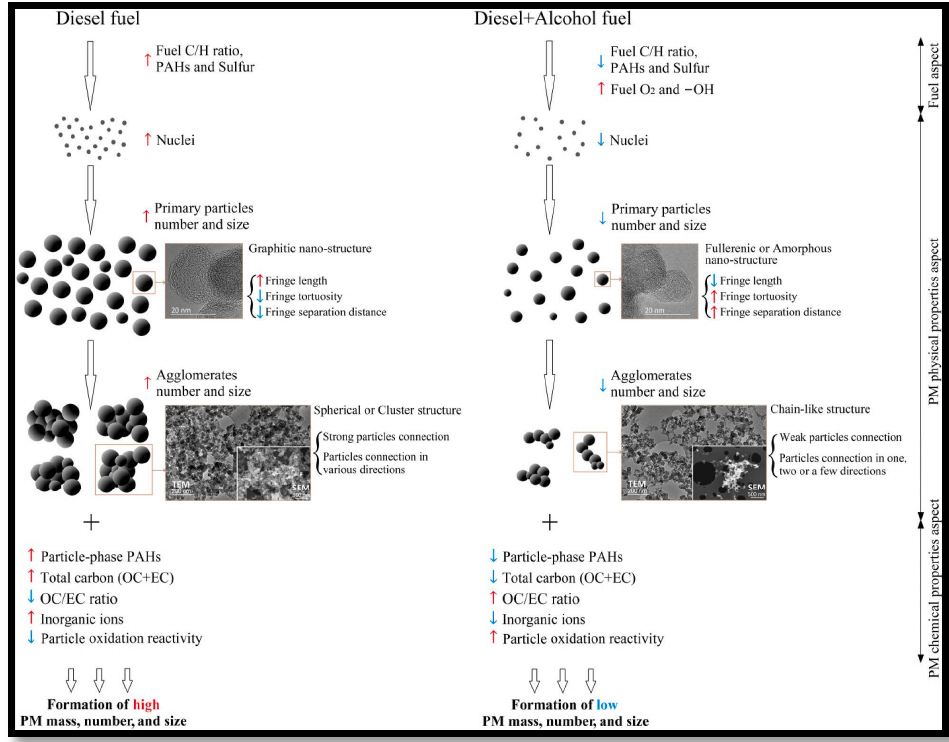
Figure 6. Effect of alcohol fuels on the PM mass, number, and size via several aspects, including fuel, PM physical, and PM chemical properties aspects.